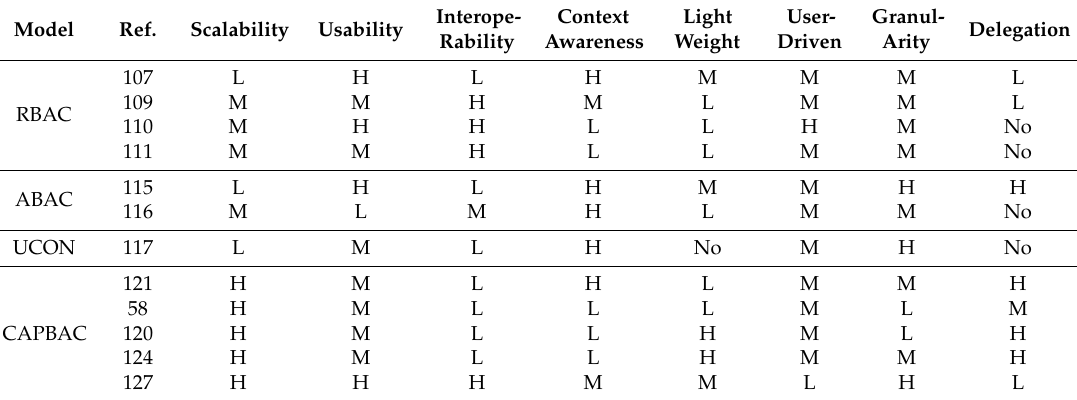
Table 3. Evaluation of IoT-based access control models according to S&PP (High = H, Medium = M and Low =